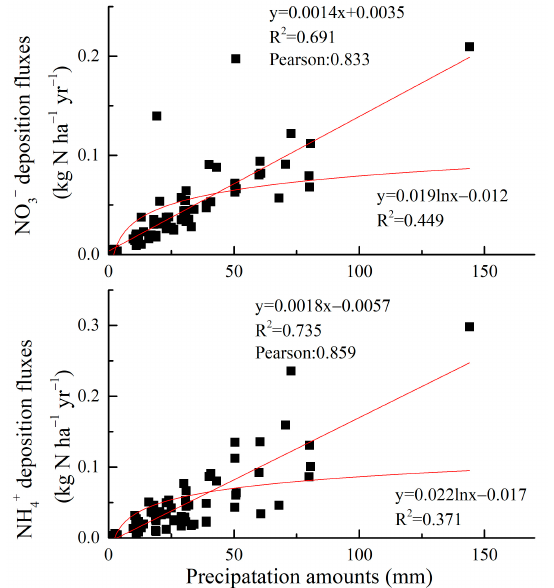
Figure 6. Linear and logarithmic relationships between precipitation and NO 3 − ( a ) and NH 4+ ( b ) concentrations. Black squares represent the Nr concentration in each precipitation sample; the red line represents the fitting line.